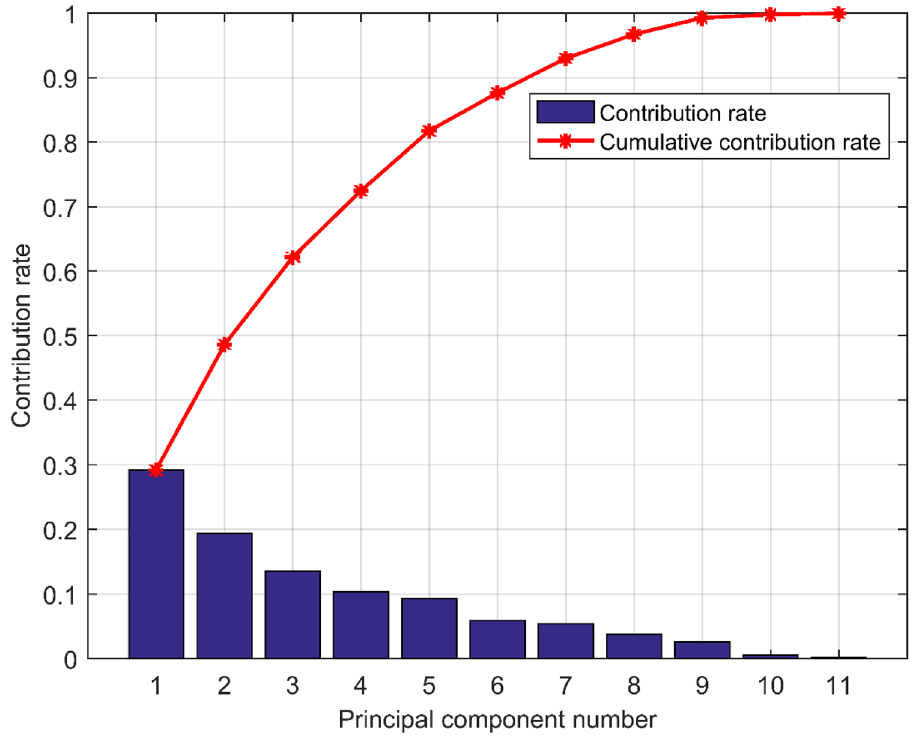
Figure 4. The principal component contribution rate and the cumulative contribution rate of the self-built point measurement